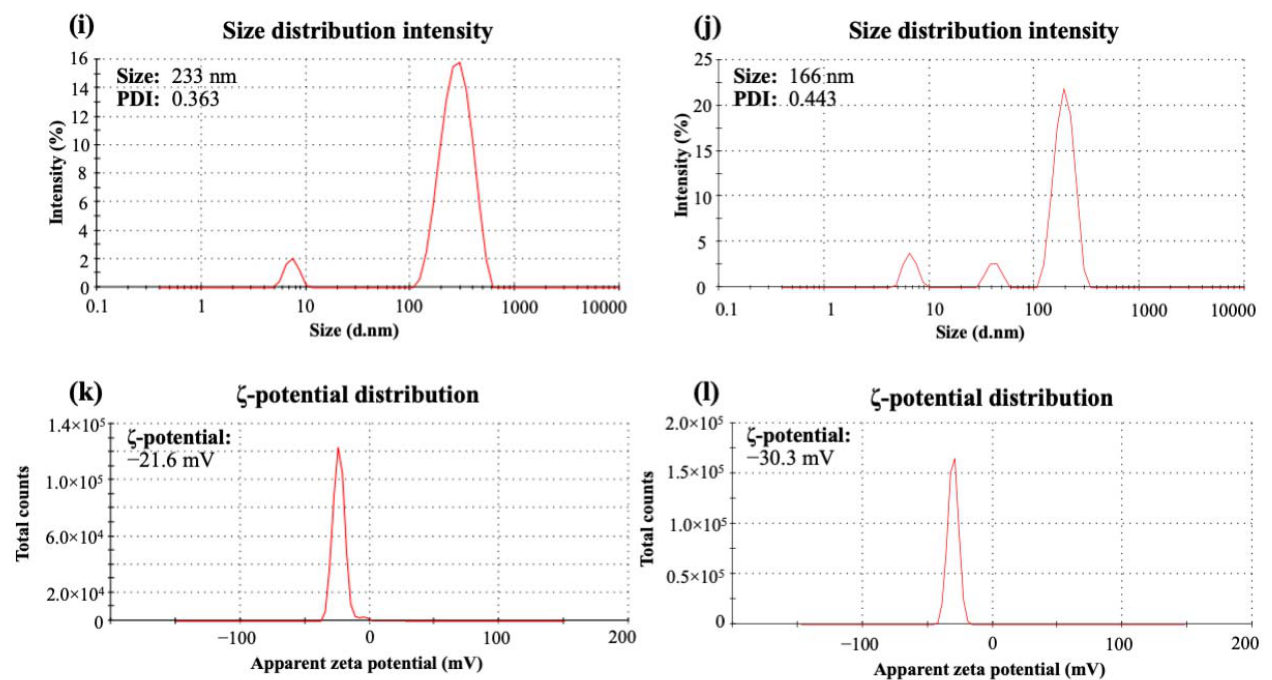
Figure 2. Characteristics of the optimized NPs: SEM images (at 50,000 × ( a , c ) and 100,000 × ( b , d ) magnification) and TEM images (100,000 × ( e , g ) and 50,000 × ( f , h ) magnifications); size distribution and ζ -potential of the optimal FVR-MCS-ALG NPs ( i , k ) and uncoated FVR-ALG NPs ( j , l ).